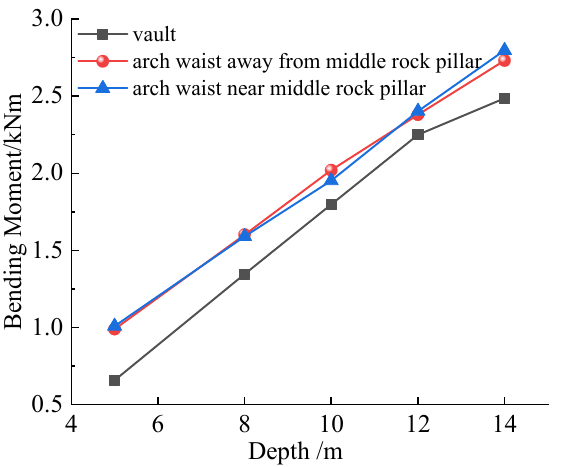
Figure 11. The bending moment of the leading tunnel in position 2 varies with the burial depth.